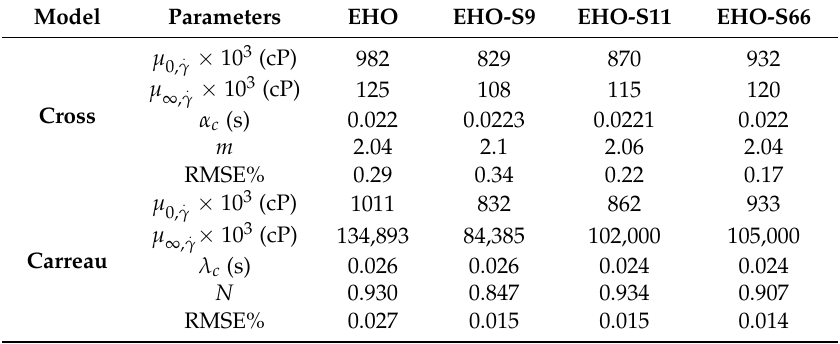
Table 4. Cross and Carreau rheological models parameters for an extra-heavy oil (EHO) in the absence and presence of 1000 mg · L − 1 of SiO 2 nanoparticles with different mean particle sizes of 9 (S9), 11 (S11), and 66 nm (S66) at 30 °C.